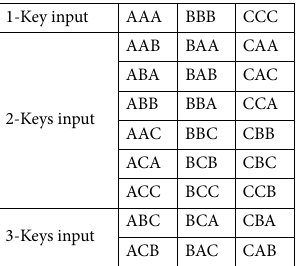
Table 2. All possible entry codes of a 3-input keypad